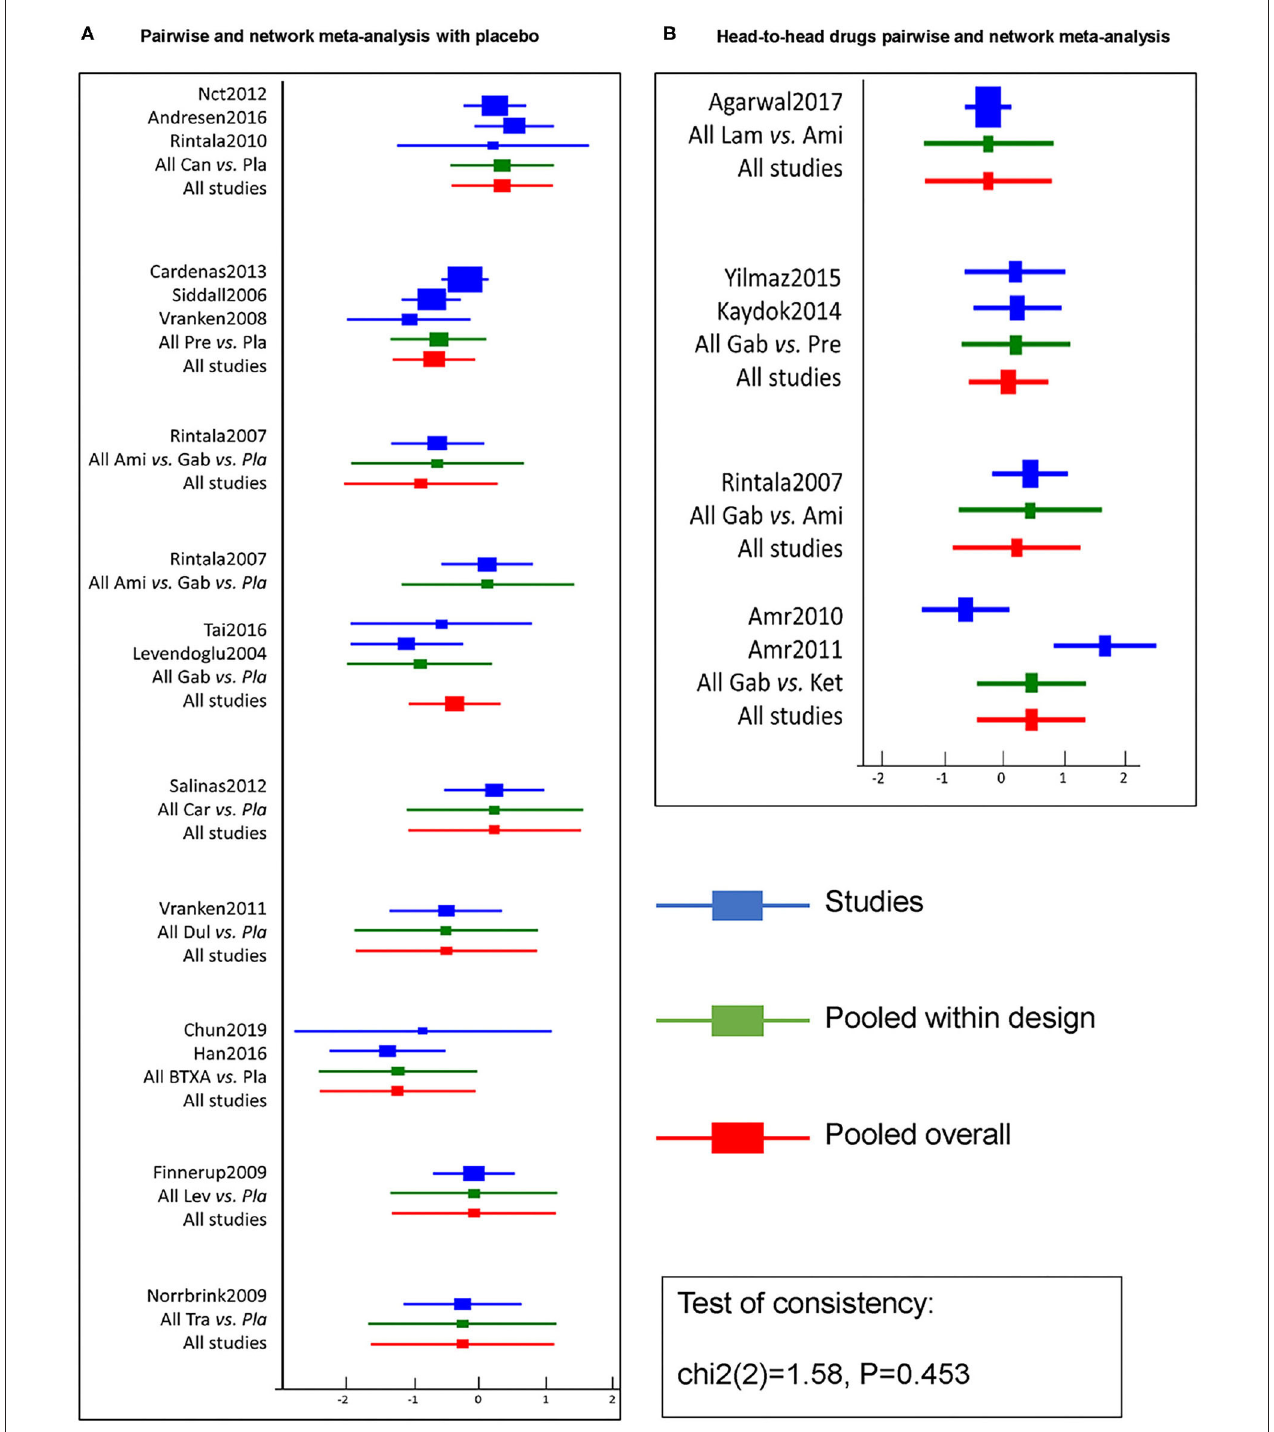
FIGURE 4 | Efficacy pairwise and network meta-analysis of 11 drugs and placebo from 20 RCTs. A forest plot (A) shows pairwise and network meta-analysis of different drugs on the target of neuropathic pain relief after SCI as compared with placebo. And the forest plot (B) shows pairwise and network meta-analysis among head-to-head drugs. The blue line in forest plots indicates the outcome analysis of corresponding studies, the green line refers to pooled within designed treatments, the red line means pooled overall. The test of consistency reveals all studies are according to the consistency model. BTX-A, botulinum toxin-A; Ket, ketamine; Ami, amitriptyline; Lam, lamotrigine; Pre, pregabalin; Dul, duloxetine; Gab, gabapentin; Tra, tramadol; Lev, levetiracetam; Car, carbamazepine; Can, cannabinoids; Pla, placebo.